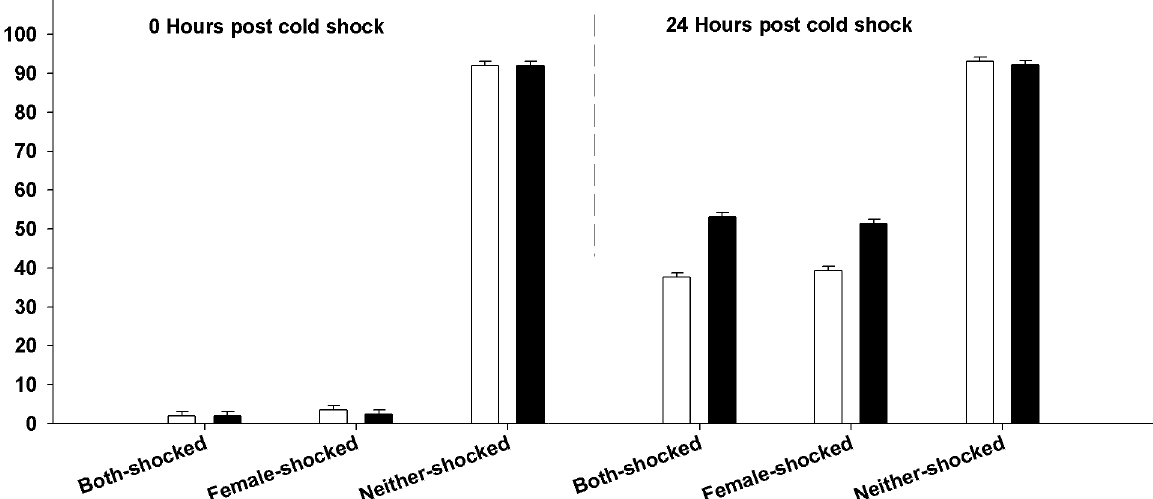
Fig 1. Effect of cold shock on fecundity. We assayed fecundity 0 and 24 hours post cold shock. Open bars represent FCB and black bars represent FSB populations. At 0 hours after cold shock, fecundity of females subjected to cold shock (Both-shocked and Female-shocked treatments) was high compared to that of females not subjected to cold shock (Neither-shocked treatment). However, there was no such difference 24 hours after cold shock. None of the differences between FCB and FSB populations were